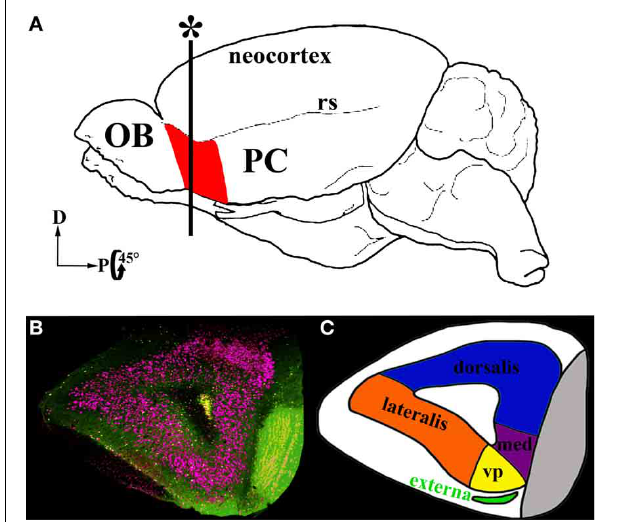
FIGURE 1 | Location and subdivisions of the AON. (A) A schematic of a whole mouse brain highlighting the AON (red) in the olfactory peduncle, just posterior to the olfactory bulb (OB) anterior to the piriform cortex (PC) and ventral to the rhinal sulcus (rs). (B) Coronal section in the plane marked with an asterisk in (A) . GAD67-GFP + cells: green, Nissl stain: pink. (C) A diagram of the subdivisions within the AON. The two major subdivisions are pars externa (green) and pars principalis. Pars principalis is further divided into pars lateralis (orange), pars dorsalis (blue), pars medialis (purple), and pars ventroposterior